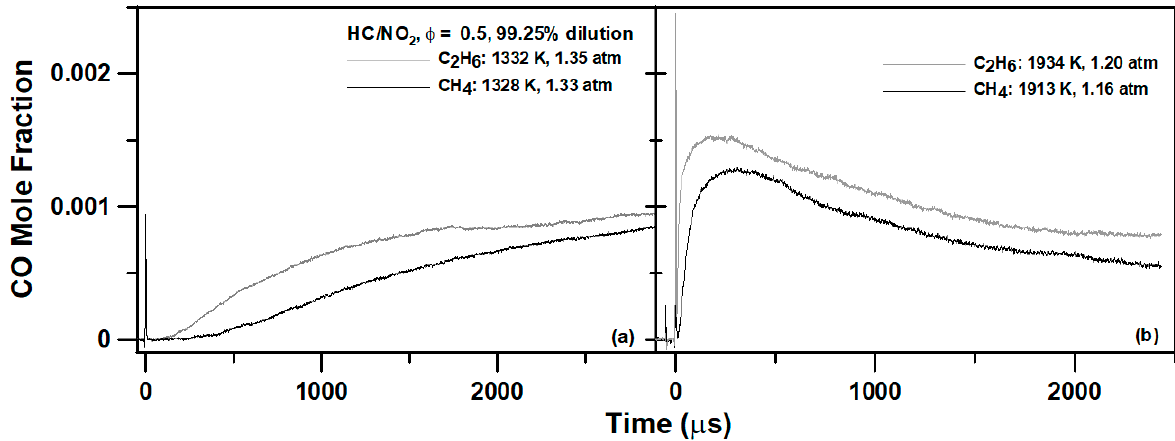
Figure 5. Comparison between the CO profiles from methane and ethane for similar conditions at around ( a ) 1330 K and ( b ) 1924